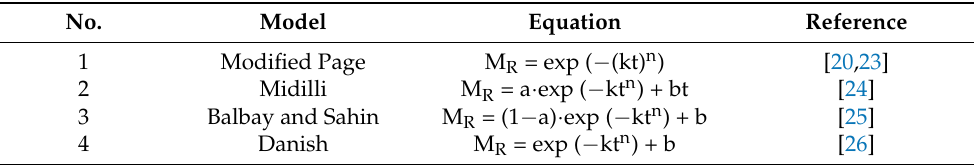
Table 1. Models of thin-material-layer drying kinetics.